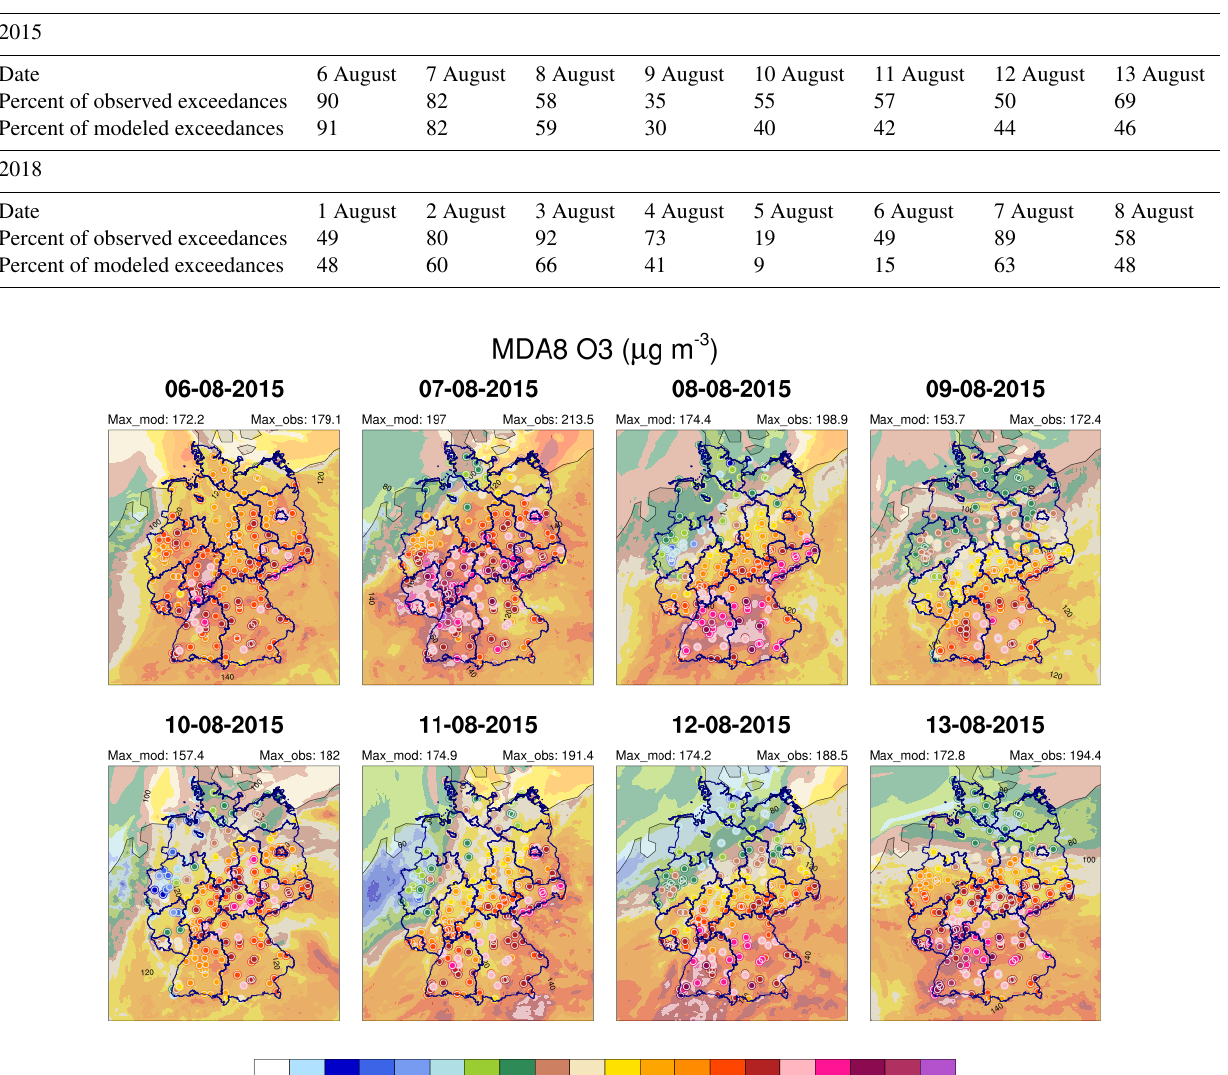
Table 6. Percentage of stations in each day that exceed the daily MDA8 O 3 target value during the periods of 6–13 August 2015 and 1–8